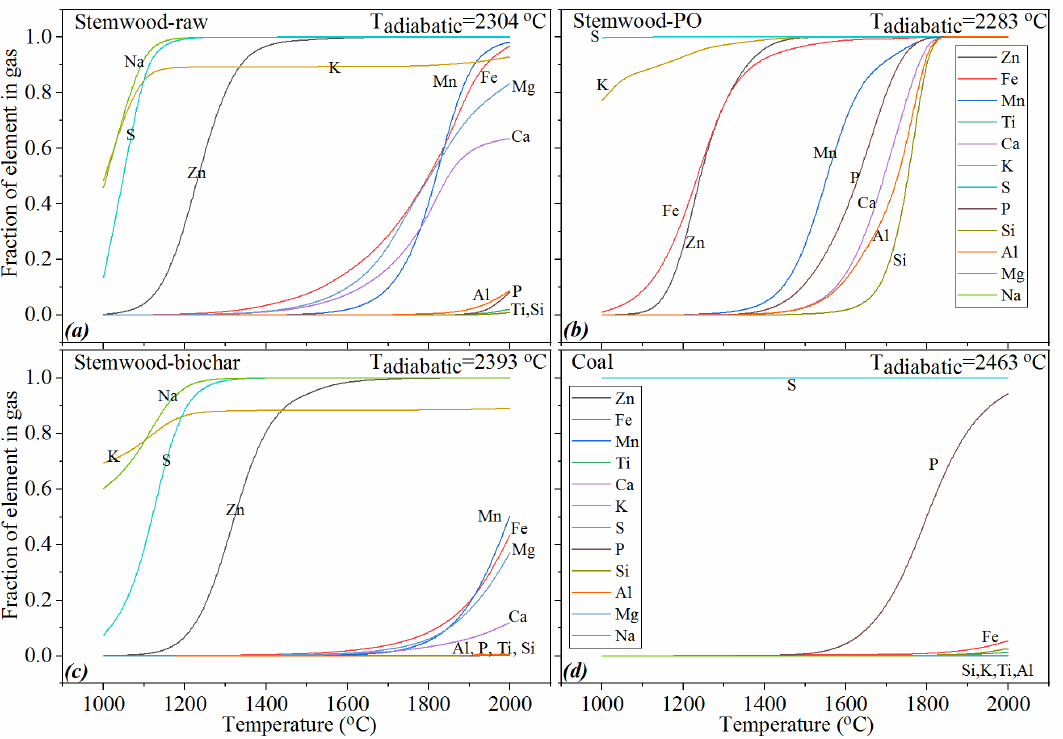
Figure 11. The predicted fraction of the inorganic elements in the gas phase for ( a ) stem wood-raw; ( b ) stem wood-PO; ( c ) stem wood-biochar; ( d ) coal.